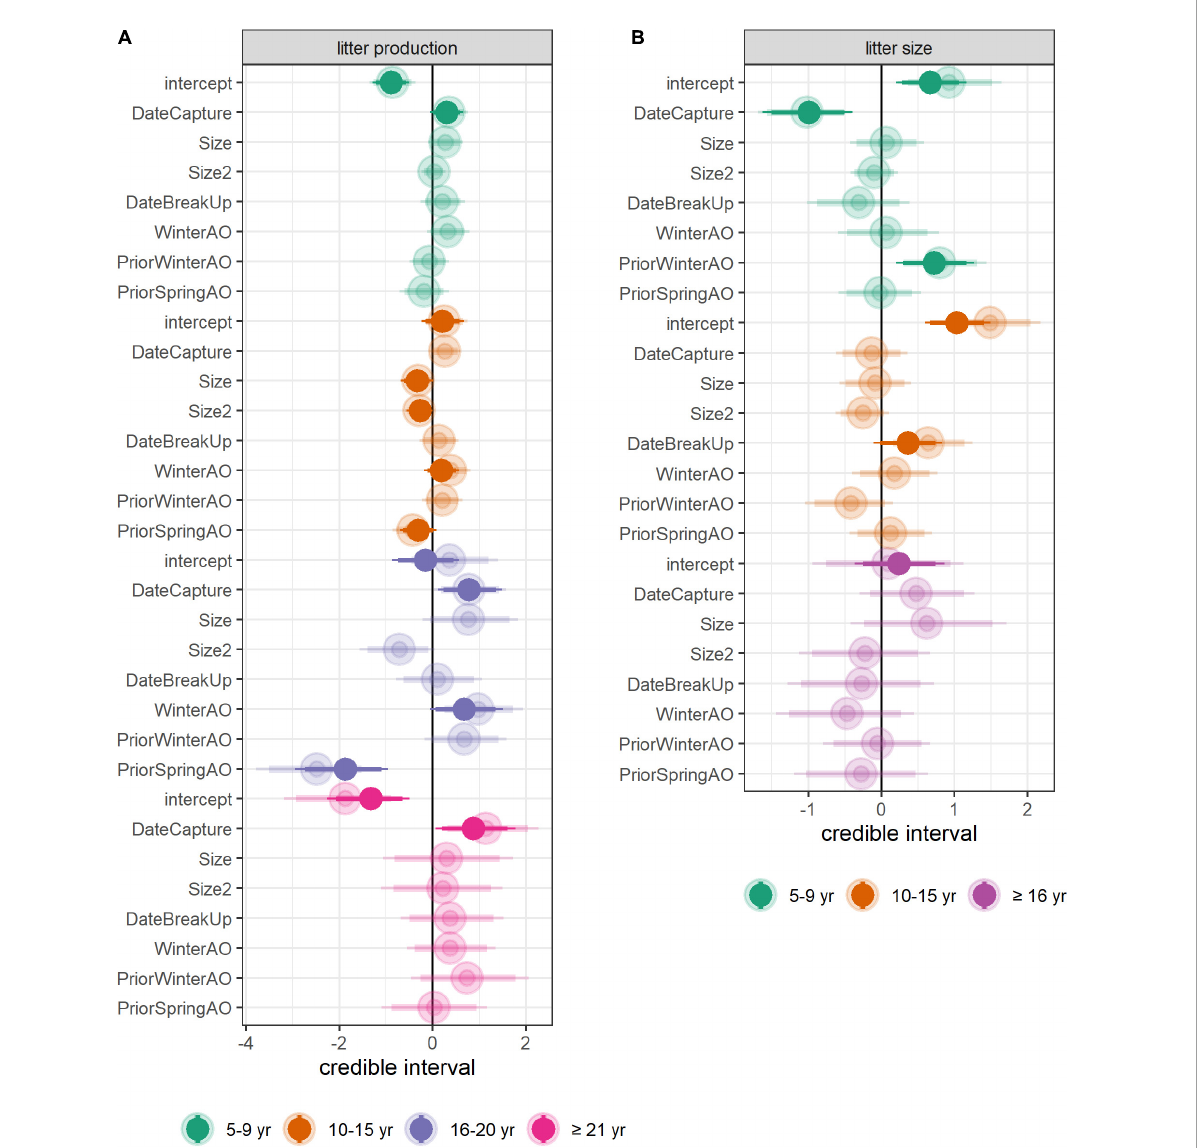
FIGURE2 Output of the models of litter production and litter size. Posterior distributions of the coefficients in the full model (transparent colors) and in the final model (solid colors) of (A) litter production and (B) litter size. The mean (dot), 89% CRI (thick line), and 95% CRI (thin line) are provided. Results are on the logit scale. DateBreakUp refers to the date of sea-ice break-up in the year prior to capture (see Appendix 3, Supplementary Figure 8 for the version of this figure obtained when using DateFreezeUp as the sea-ice covariate), WinterAO , PriorWinterAO , and PriorSpringAO , respectively refer to the mean Arctic Oscillation index over the winter of the year of capture, over the winter of the year preceding capture and over the spring of the year preceding